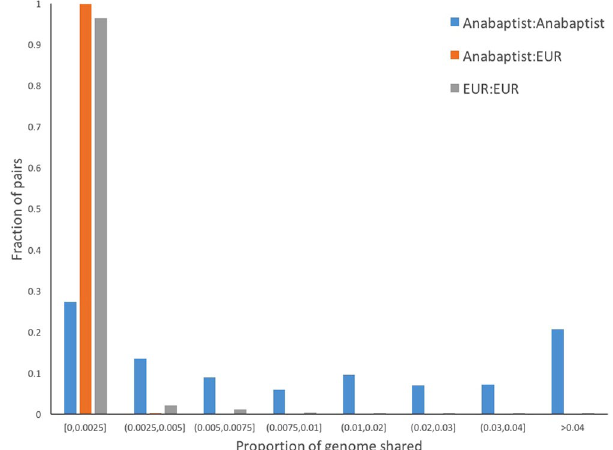
Figure 5. Increased distant relatedness among Anabaptists. The distribution, over all pairs of individuals, of the fraction of the genome shared IBD (segment lengths ≥ 3 cM) either within AGRP (Anabaptist, blue), within Europeans (EUR, grey), or between Anabaptists and EUR (orange).